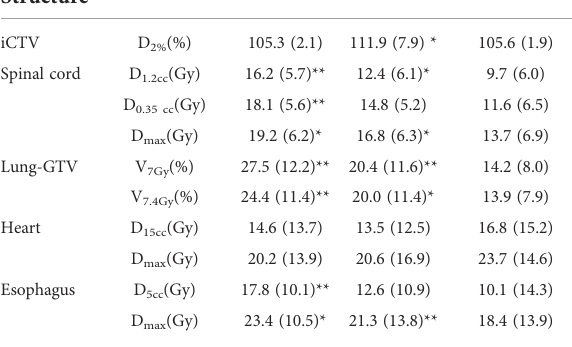
TABLE 1 Summary of dose metrics of RT structures in Trx-5fds, Trx- 3fds and IMPT plans. RT Dose metric Structure